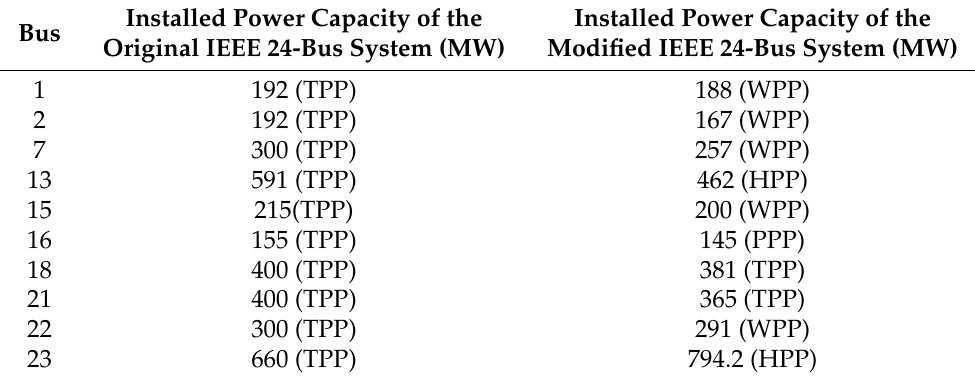
Table 1. Installed power capacity of the original and modified IEEE 24-bus system. Data source: [27,42].